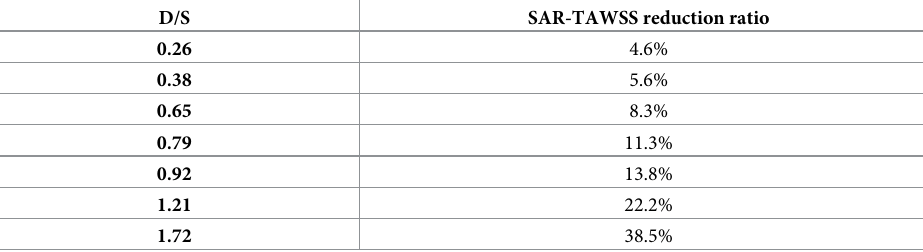
Table 3. The variation of SAR-TAWSS reduction ratio (during EECP vs. before EECP) in seven patients with dif- ferent D/S (the real value of D/S during